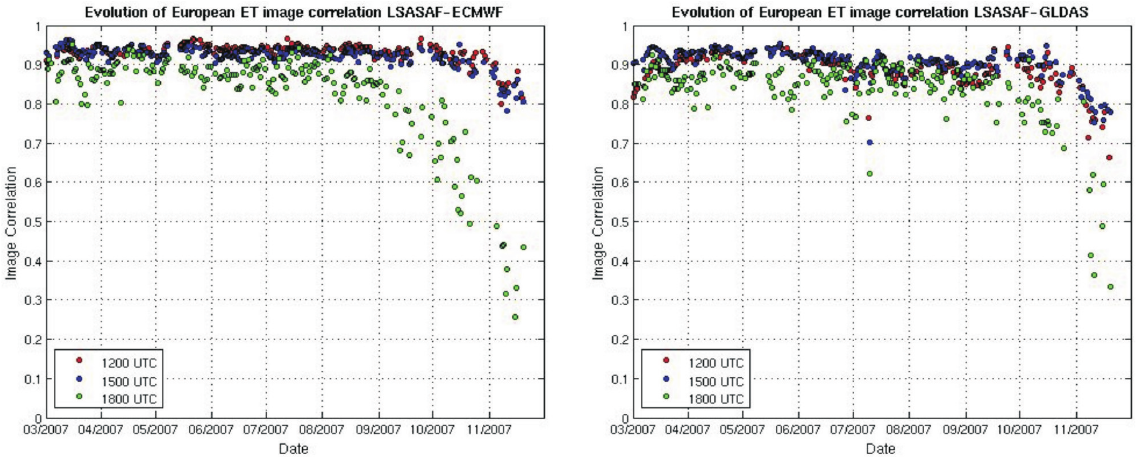
Fig. 5. Evolution of 3-hourly mean image correlation over MSG European window between LSA-SAF ET and ET ECMWF forecasts (left), and with GLDAS ET images (right), from March to November 2007.